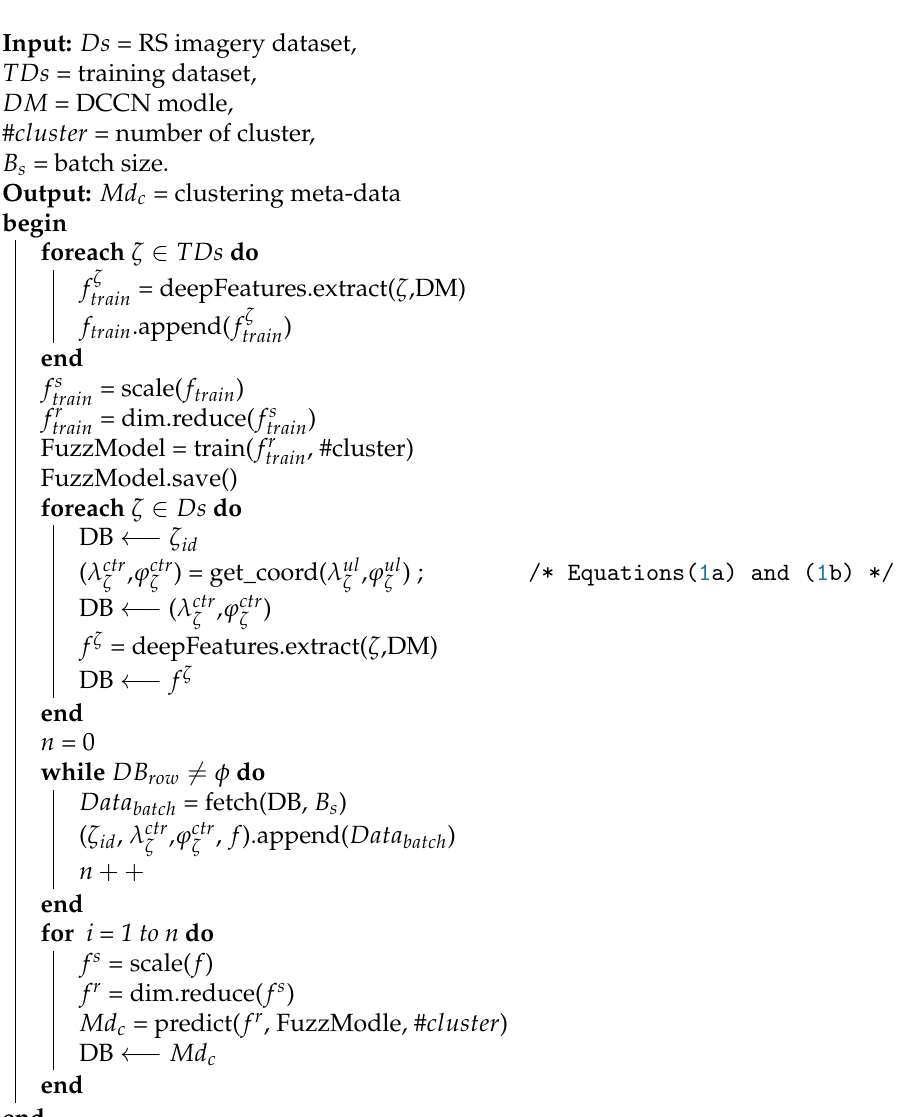
Algorithm 2: Feature Extraction and